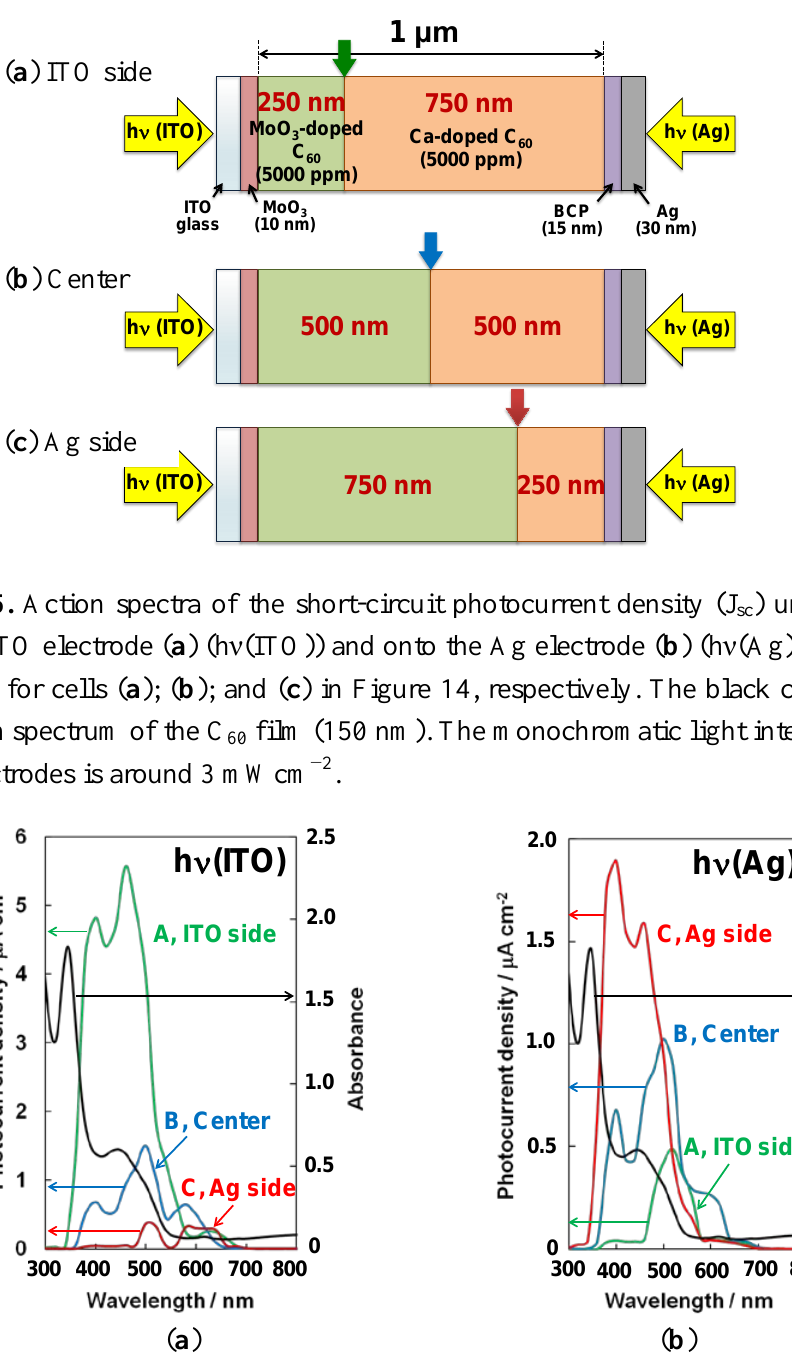
Figure 14. Three structures of pn -homojunction C cells. The thickness combinations of 60 the MoO - and Ca-doped layers are 250/750 nm ( a ); 500/500 nm ( b ); and 750/250 nm ( c ). 3 The concentration was kept at 5000 ppm for both dopants. Hν (ITO) and hν (Ag) denote light irradiation onto the ITO and onto Ag electrodes, respectively. The locations of the homojunctions are indicated by the arrows.